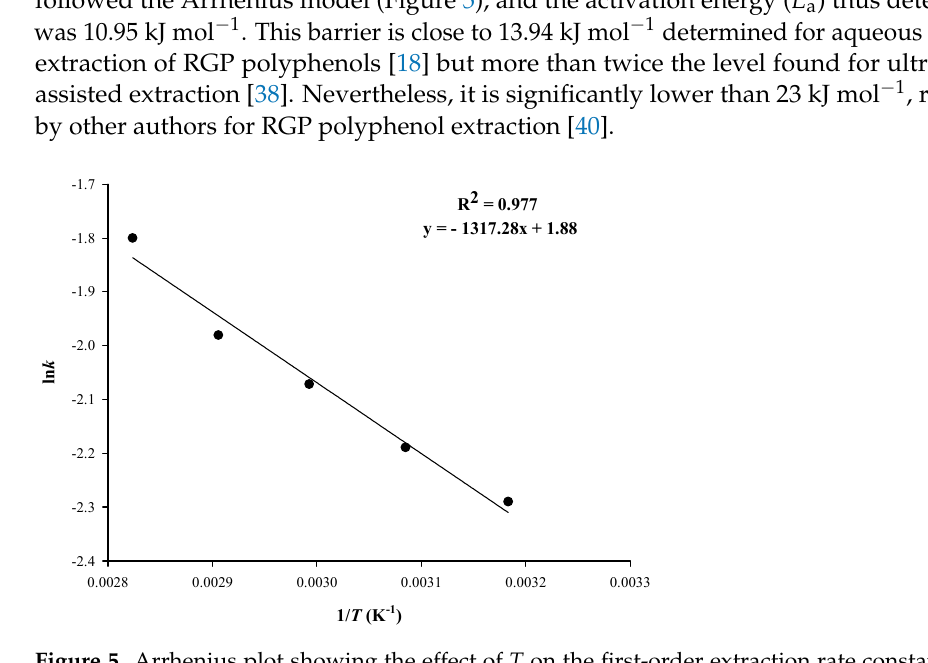
Figure 5. Arrhenius plot showing the effect of T on the first-order extraction rate constant, k . Extractions were performed under optimized conditions ( C CD = 1.5%, t us = 30 min, R L/S = 90 mL g − 1 ), under stirring at 900 rpm, for 180 min.